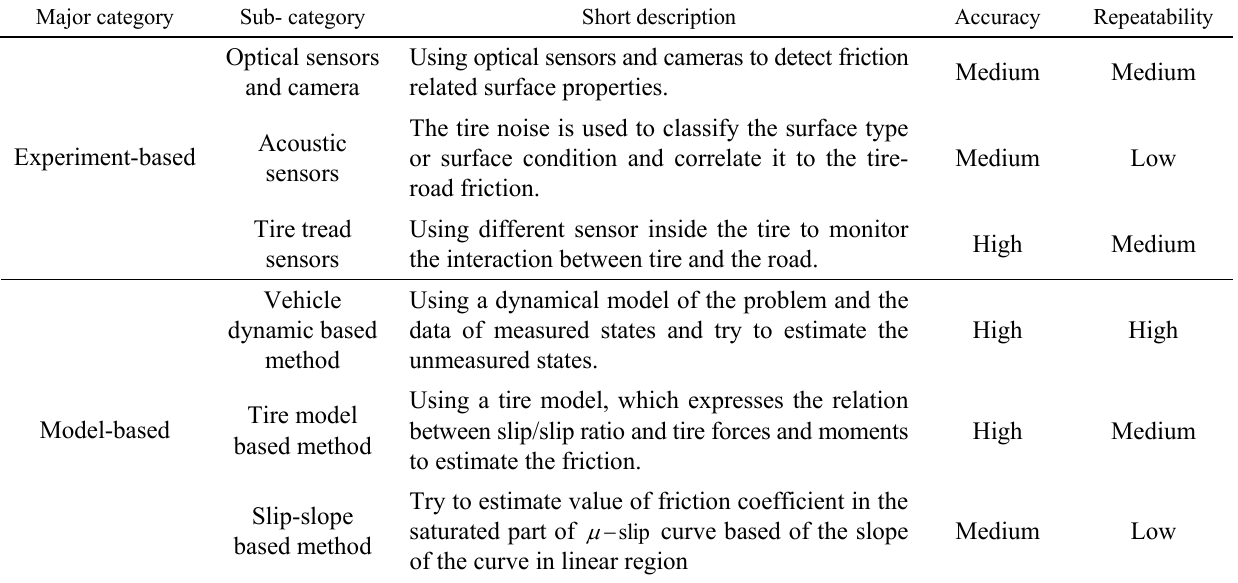
Table 8 Summary of friction estimation